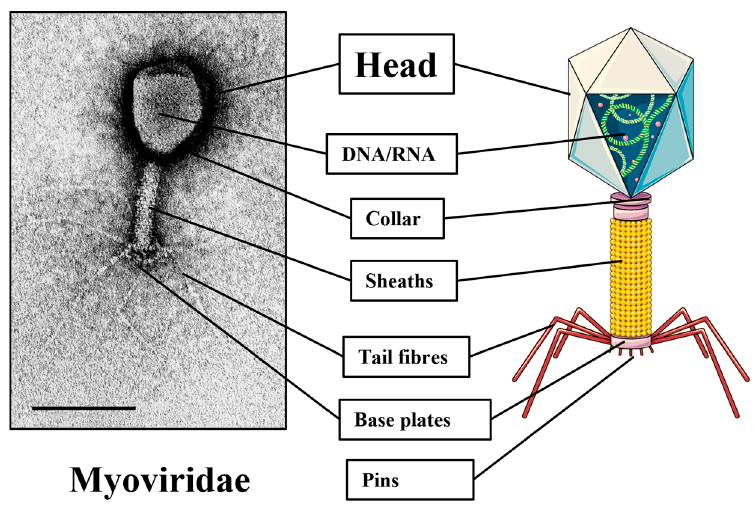
Figure 1. Typical structure of bacteriophages under the microscope and schematically.